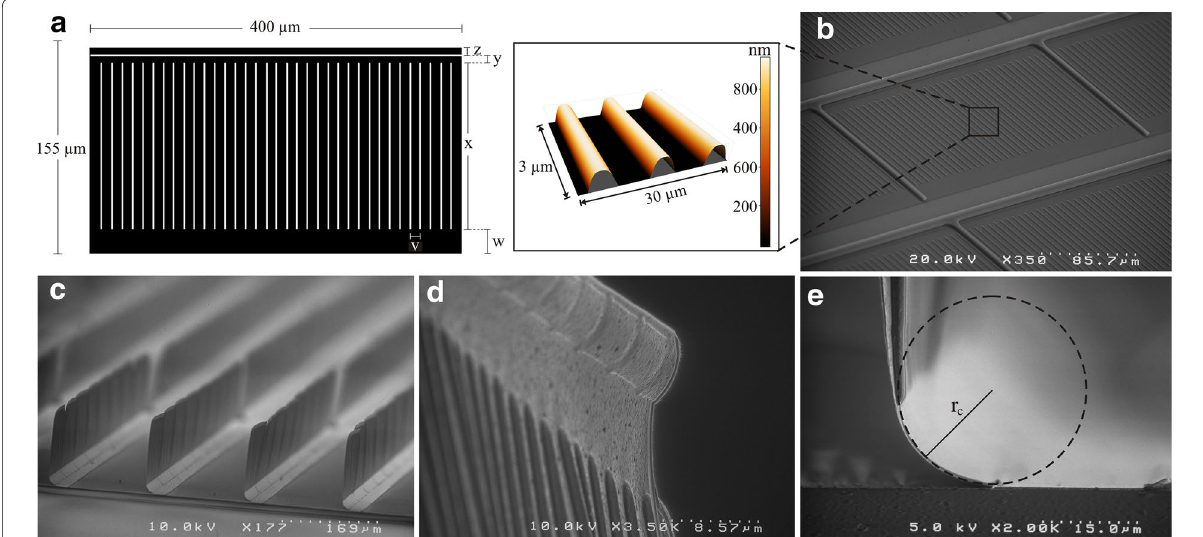
Fig. 5 Schematic of sub-structure design III with mirror dimensions and geometric parameters v - z ( a ), profile of the corresponding structured photoresist layer analyzed by SEM and a close-up of the parallel lines of design III analyzed by AFM ( b ), SEM image of the resulting micromirrors with entirely planar mirrors ( c ), close-up SEM image of the mirror plane corner ( d ), close-up SEM image of the hinge area with the depicted radius of curvature r c (e). Within our structure screening, design III was identified to work best